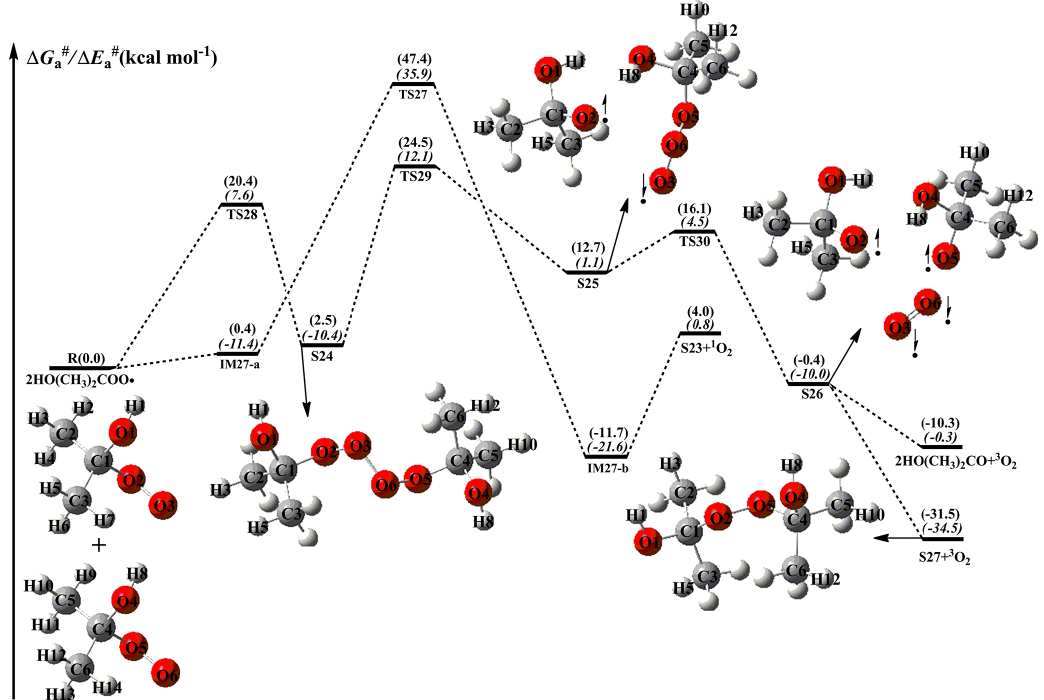
Figure 7. PES ( (cid:49)G # a and (cid:49)E # a , in italics) for the self-reaction of HO(CH 3 ) 2 COO radicals predicted at the M06-2X/ma-TZVP//M06-2X/6- 311+G(2df,2p) level of